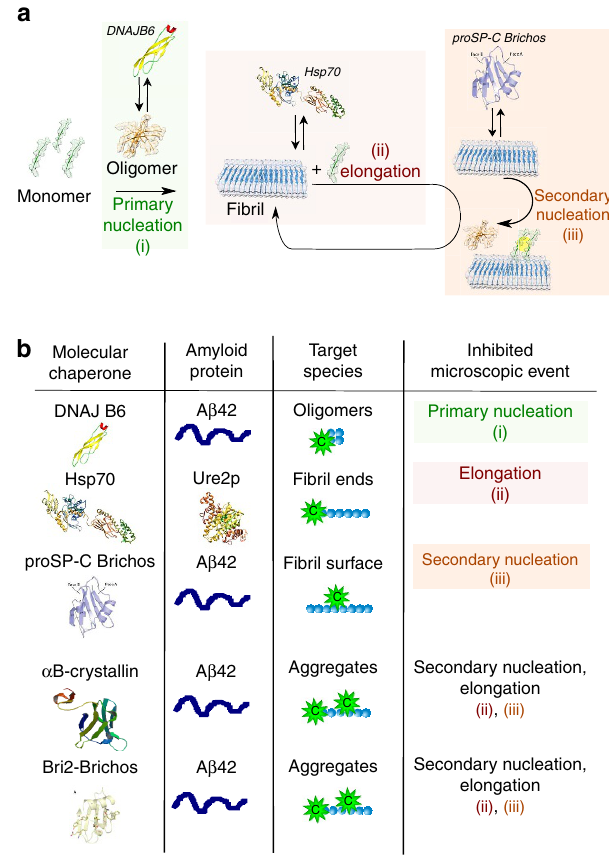
Figure 5 | Summary of the diverse modes of action. Overview of the variety of diverse microscopic mechanisms through which molecular chaperones can suppress amyloid formation, as revealed by the kinetic analysis presented in this work. As we demonstrate, molecular chaperones have evolved to exploit in a variety of ways the different opportunities to modulate protein aggregation offered by the binding to different protein species (Fig.